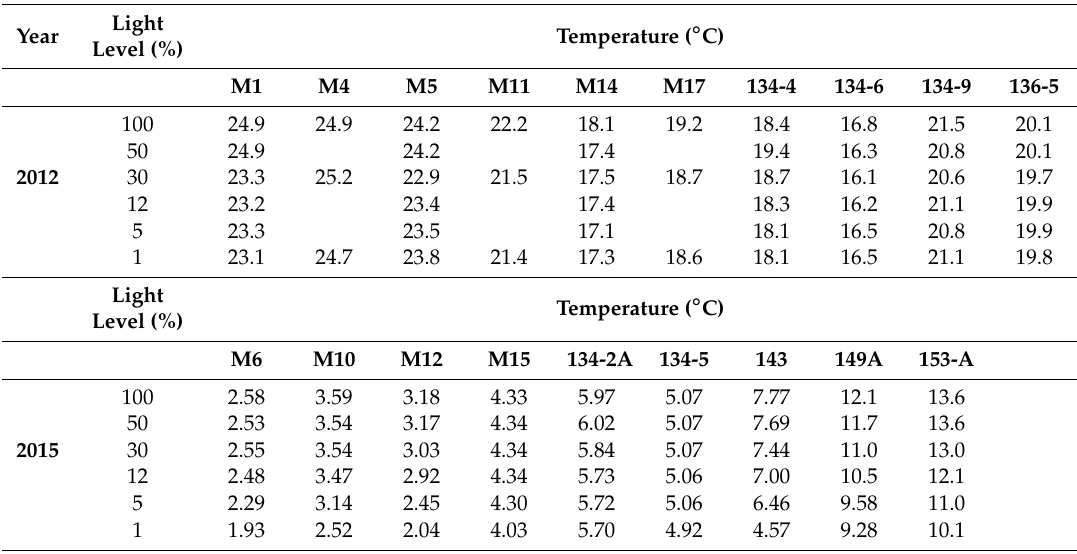
Table 1. Temperature data from the sampling stations during the fall in 2012 and early spring in 2015 sampling in the East / Japan